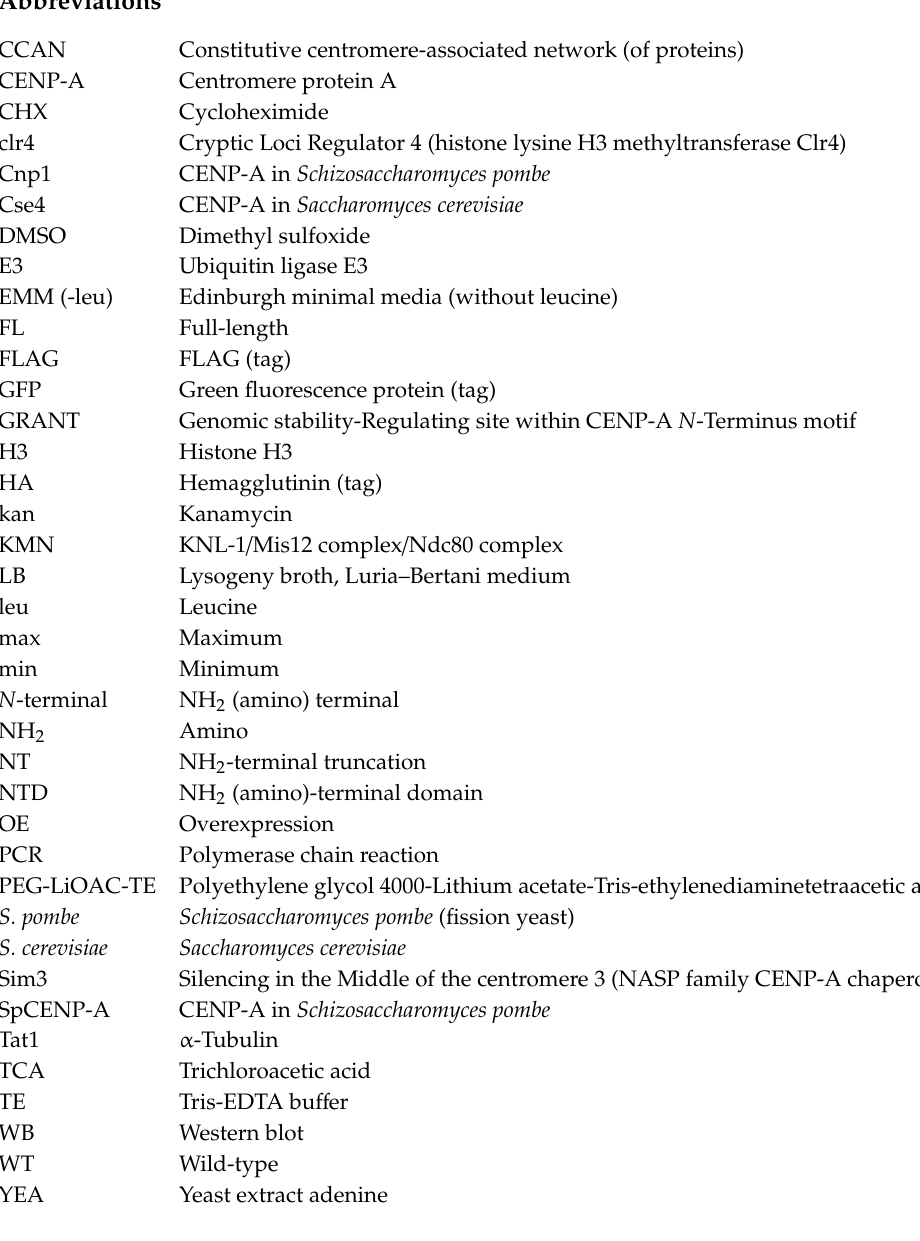
constructs synthesised for this study; Table S3: Antibodies used in study; Figure S1: Protein turnover of FLAG-tagged SpCENP-A under cycloheximide